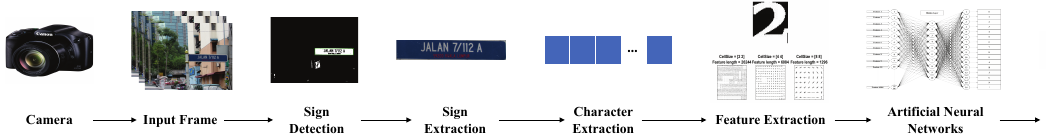
Figure 1. Overview of the proposed system for automatic street sign identification and